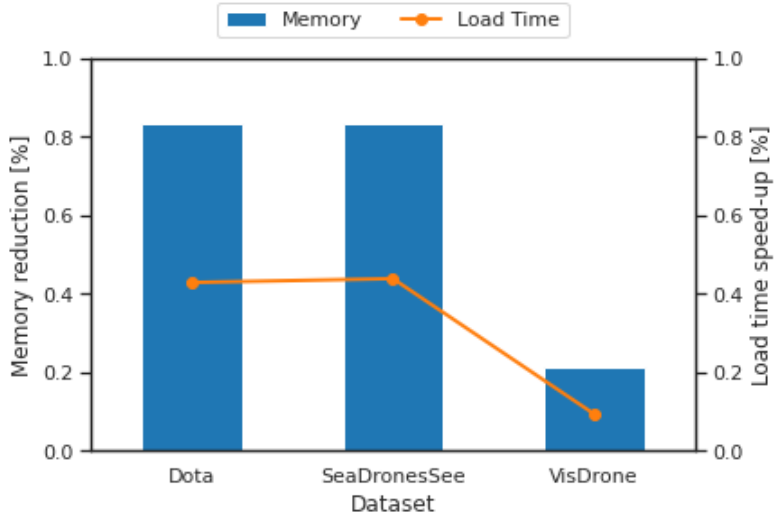
Figure A11. Space reduction and loading time speed-up for the different data sets